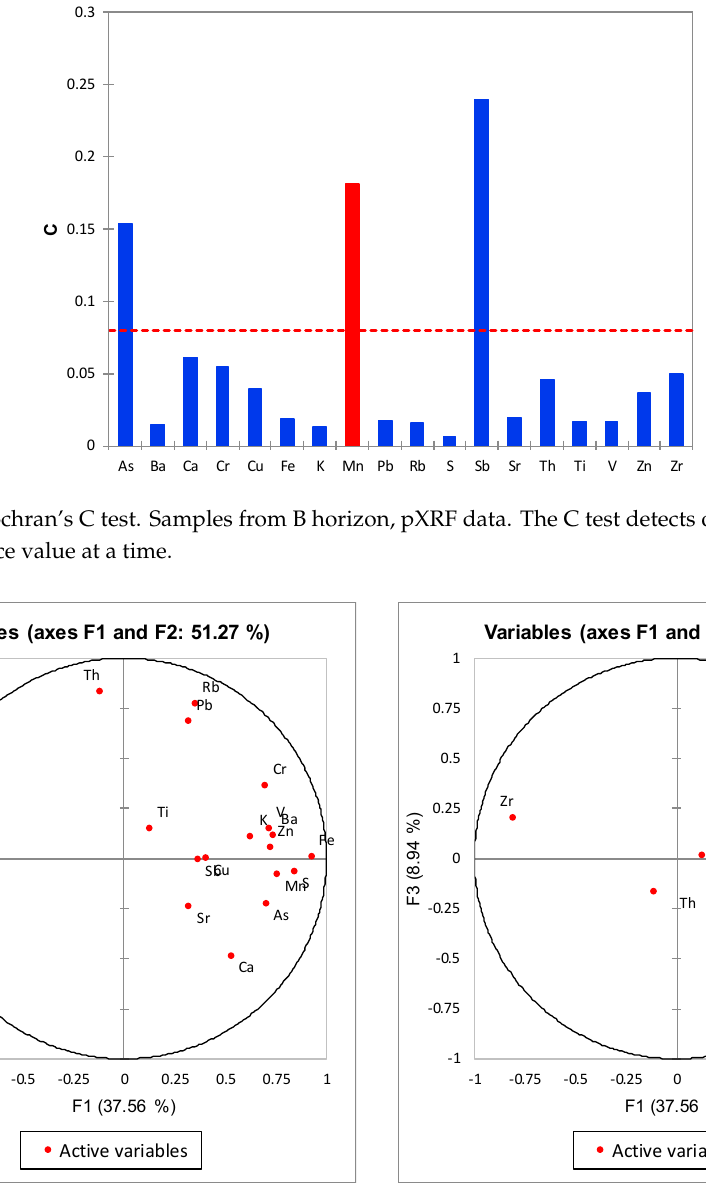
Figure 4. Pearson correlations on clr data for B horizon Group B observations, pXRF measurements. The use of colour shading and its interpretation is described in [35].